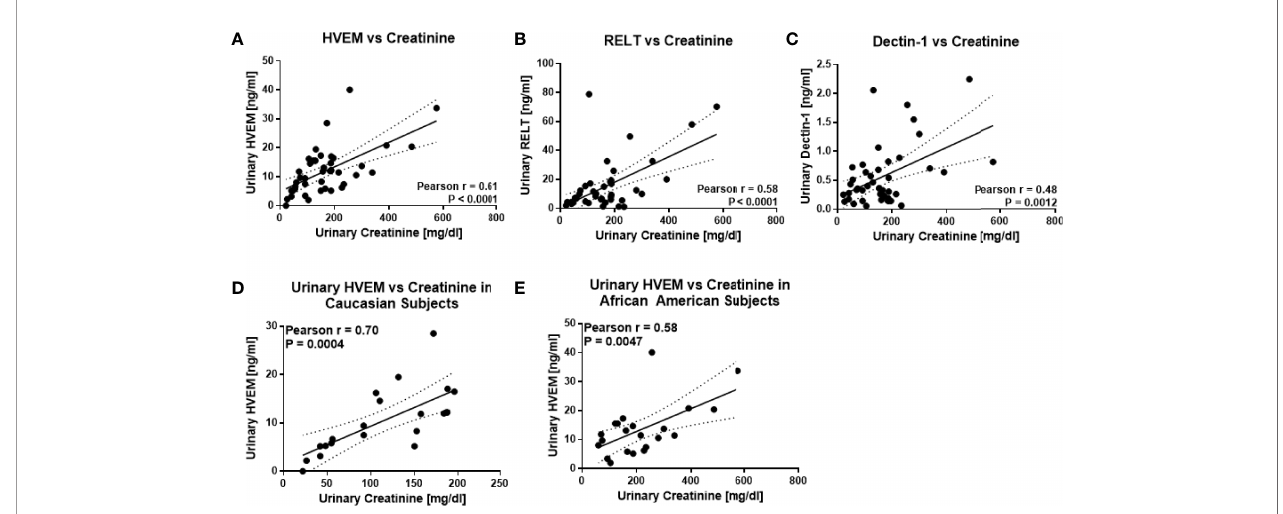
FIGURE 4 | ELISA validation of the top urine protein candidates in an independent cohort of 14 active LN, 13 inactive LN, 16 healthy control subjects. Urine samples were pretested for dilution and assayed for urinary HVEM (A) , urinary RELT (B) , and urinary Dectin-1 (C) in these 43 urine samples. A signi fi cant positive correlation was noted between urine HVEM and RELT with urinary creatinine. Urine HVEM, the most promising biomarker for urine biomarker normalization, was assayed in 21 Caucasian (D) and 22 African American (E) subjects, again showing a signi fi cant positive correlation with urine creatinine across both races.